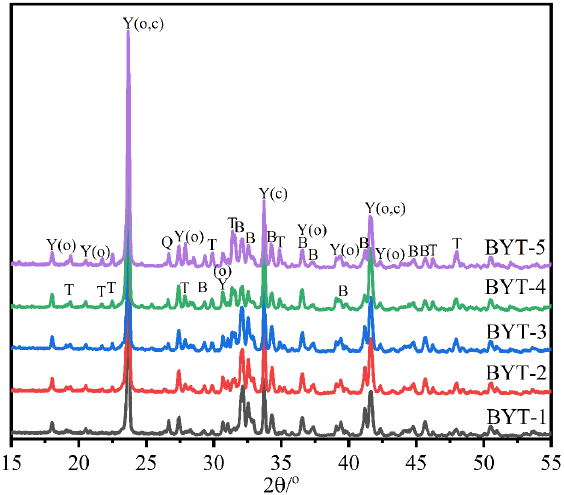
Figure 2. X-ray diffraction pattern of the BYT clinkers (B-C 2 S, Y-C 4 A 3 $, T-C 5 S 2 $, Q-SiO 2 ). Table 5. Phase composition measured by XRD-Rietveld refinement and Rwp values for all clinkers. Phase